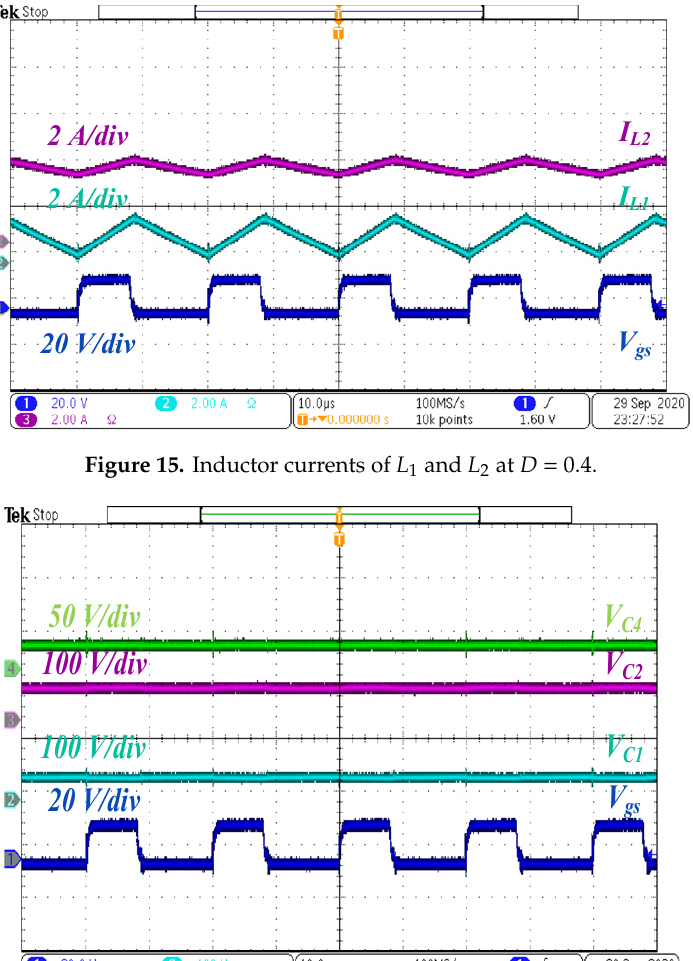
Figure 17. Output voltage and voltage stress across switch S 1 and S 2 at D = 0.4. 6. Efficiency Calculation For the calculation of efficiency, the power loss in each component needs to be determined. The losses in switches are bifurcated into switching and conduction losses. The parasitic and ON state resistances are shown in Table 2. The total switching loss in switches S 1 and S 2 is found to be 0.298 W. The total conduction loss is found to be 0.773 W. The loss in capacitors: